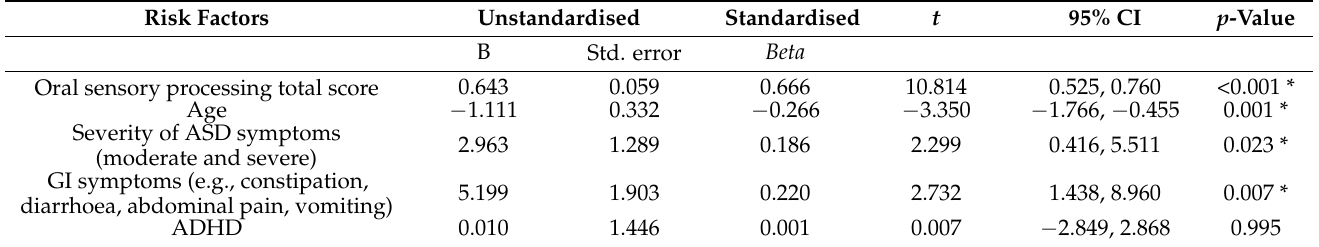
Table 5. Simple linear regression between oral sensory processing, age, severity of ASD symptoms and health-related comorbidities.